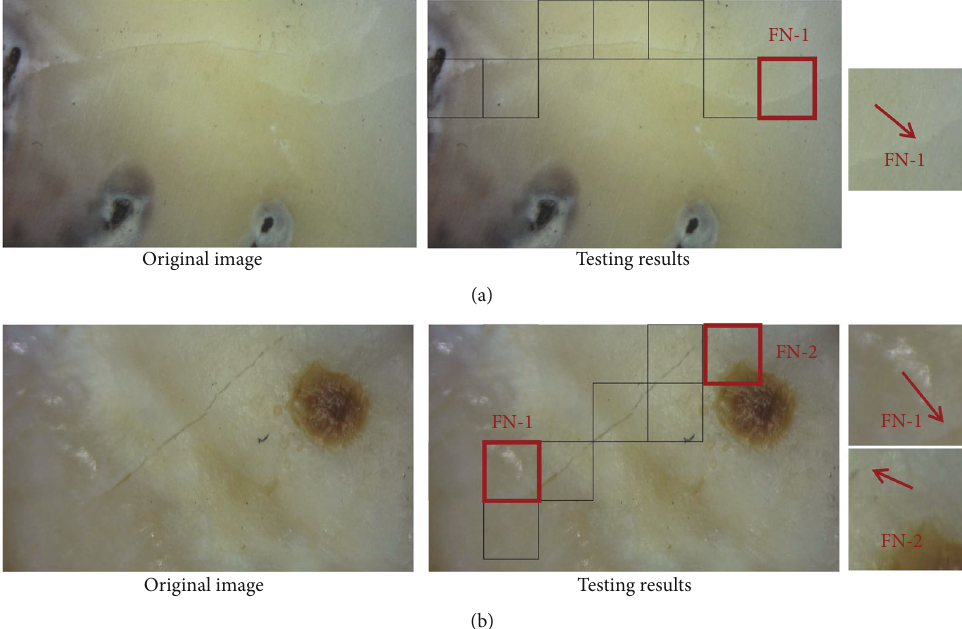
Figure 10: Testing results for image containing other diseased tooth surfaces. (a) Cavities exist on the tooth surface with tiny cracks; and (b) tooth surface with dental plaque with normal cracks. The red arrows point to the